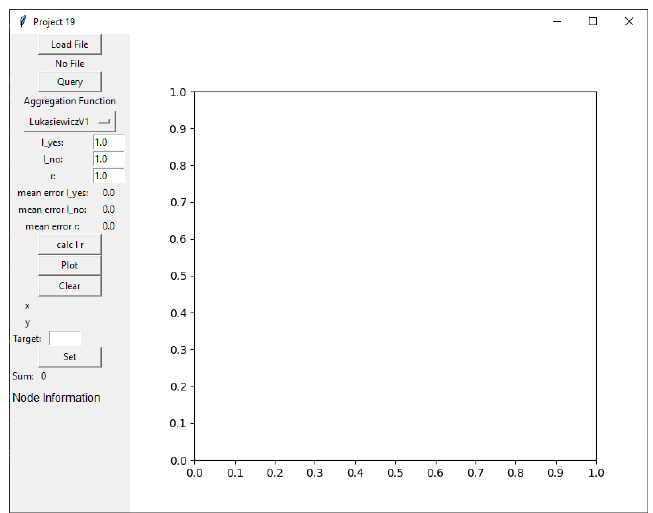
Figure 13. The initial state of the tool for the visualisation of the